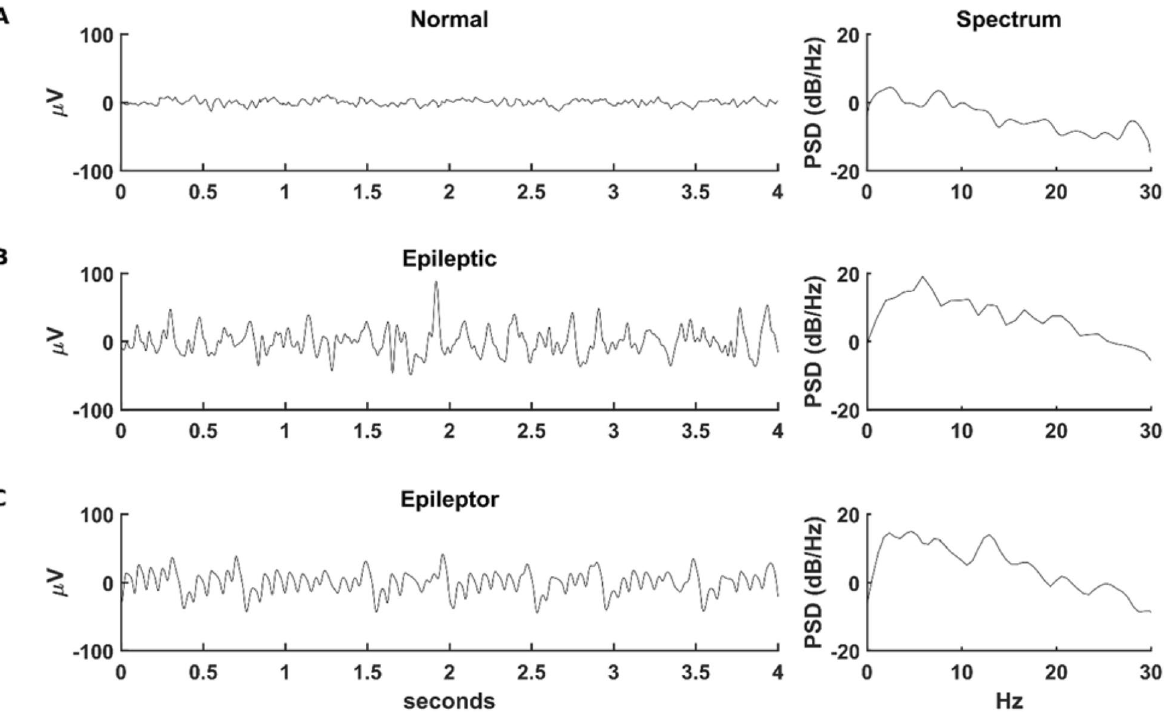
Figure 1. Comparison of experimental and model traces. ( A ) typical EEG trace under control conditions (left, from 12 ), and the corresponding Welch spectrum (Right); ( B ) typical EEG trace during epileptiform activity (from 13 ); ( C ) time course of the variable corresponding to the membrane voltage during a simulation of an Epileptor 15 with parameters: a = 1, b = 3, c = 1, d = 5, I ext1 = 3.1, m = 0, a 2 = 6, τ 2 = 10, I ext2 = 0.4, γ = 0.01 and a white noise of amplitude 0.25. The adimensional model has been converted in a dimensional one using the time scale constant 0.0167 s and the voltage scale constant 25